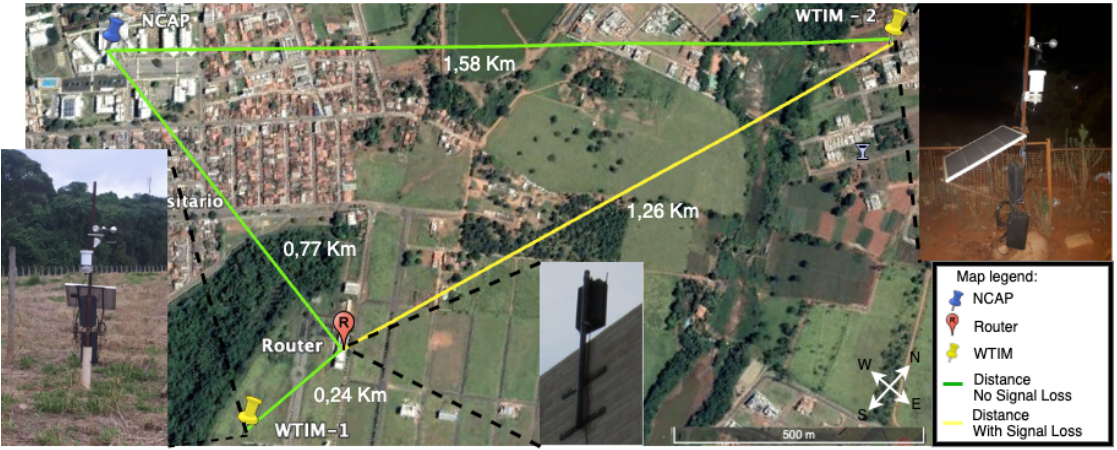
Figure 10. Network topology applied in the